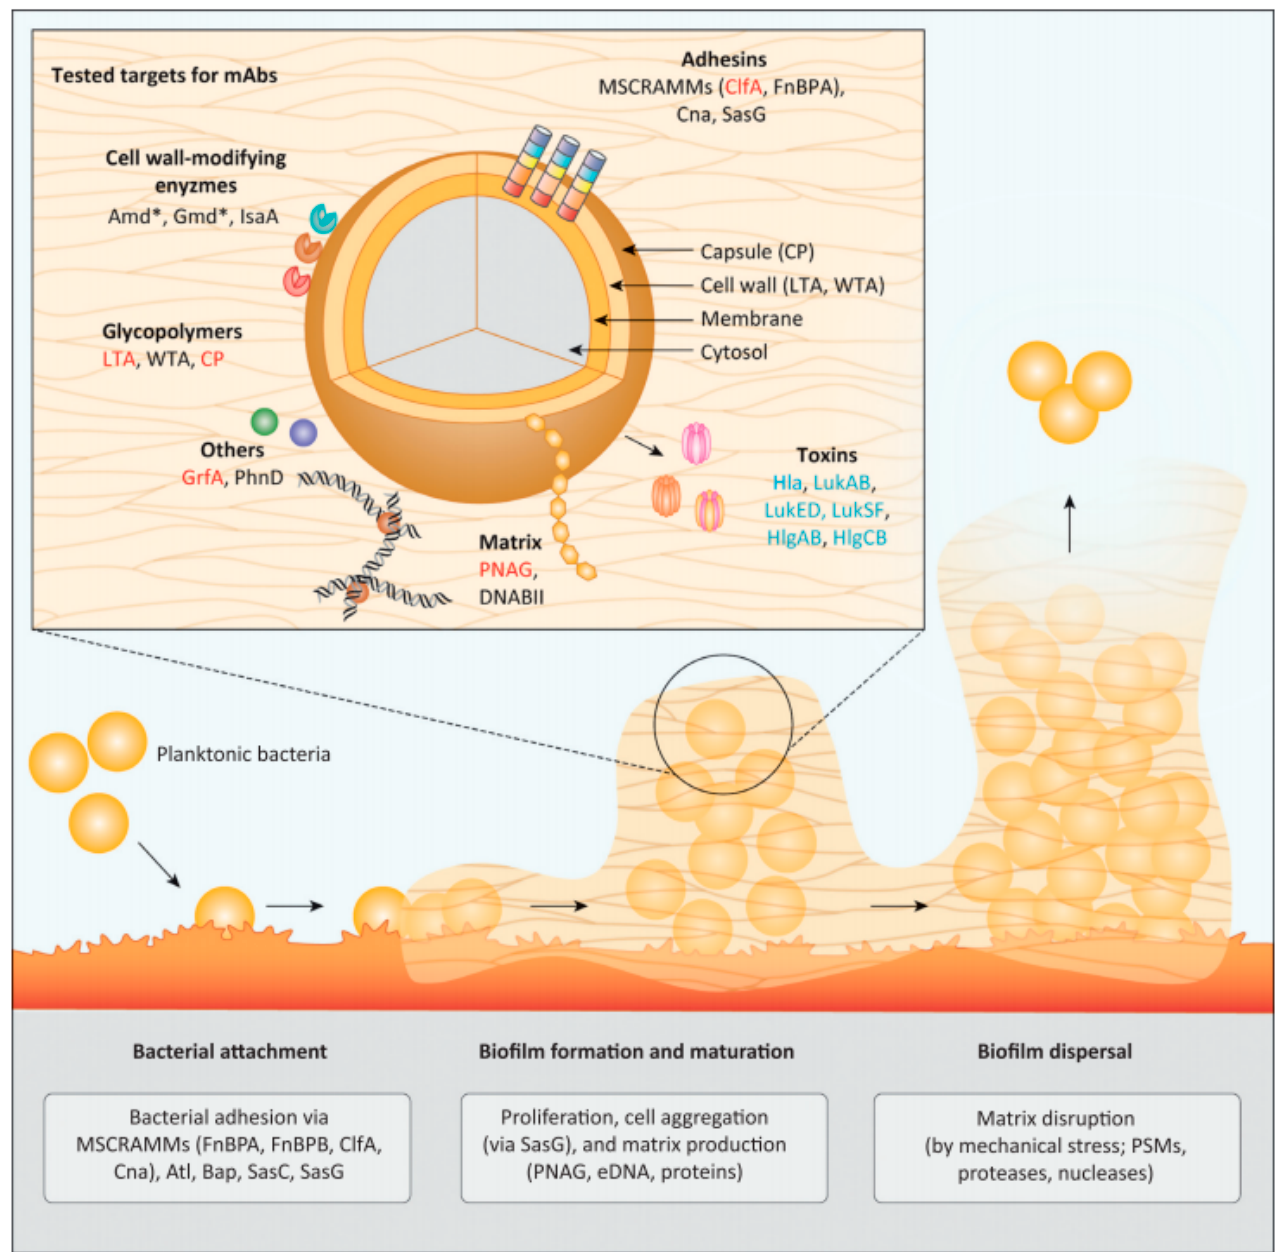
Figure 4. Potential molecular targets involved in Staphylococcus biofilm formation. The biofilm could be disrupted by generating antibodies against functional proteins involved in each stage of biofilm formation. Adapted with permission from Raafat et al. [42]. 2019,